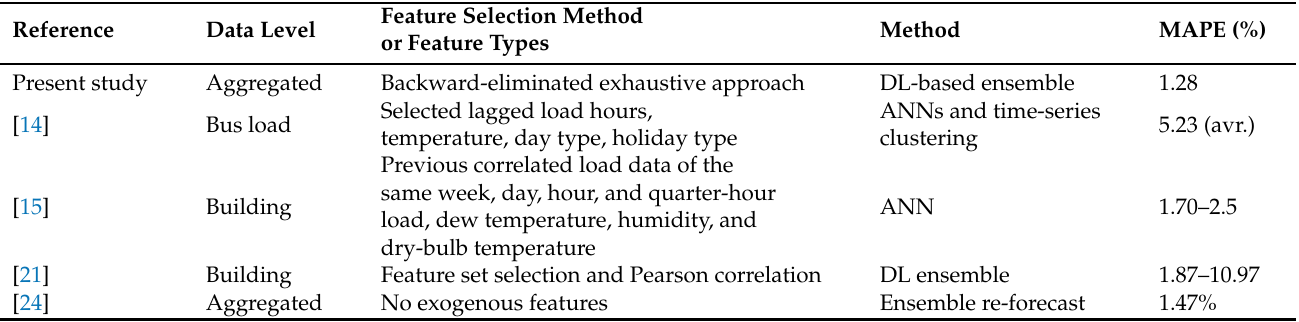
Table 3. Benchmarking